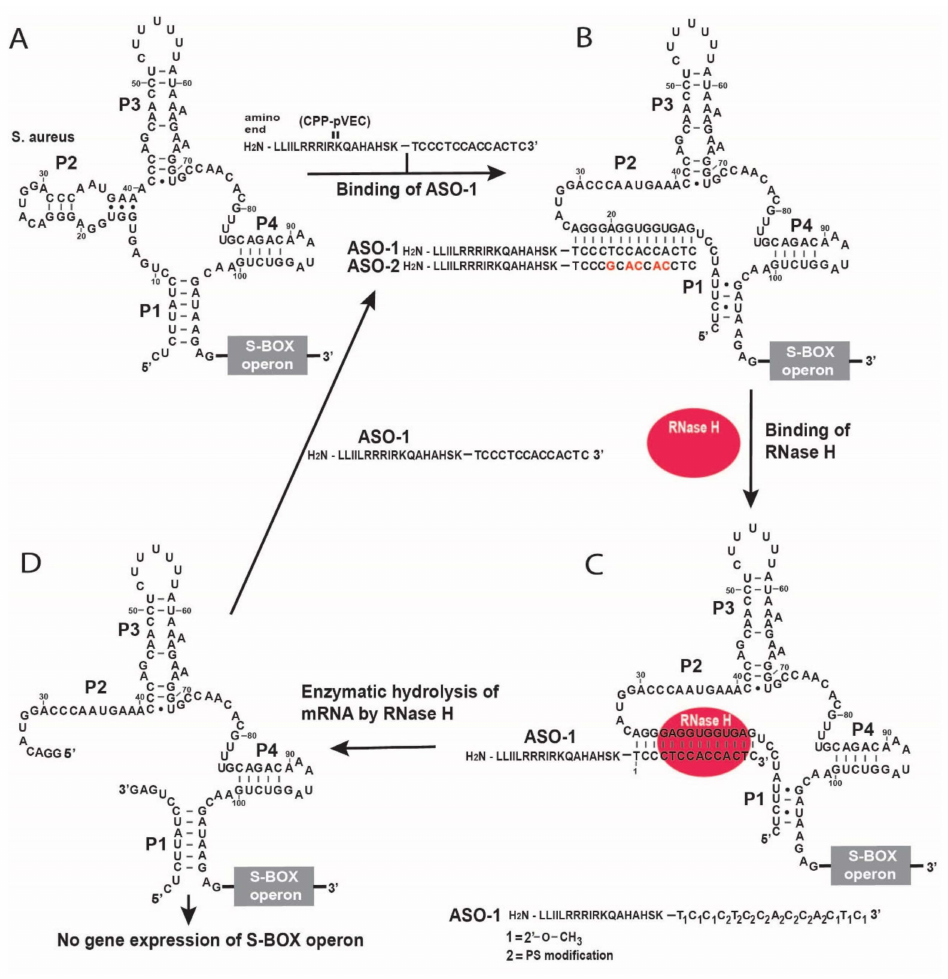
Figure 1. A chimeric antisense oligonucleotide pVEC-ASO-1 targets the SAM-I aptamer domain of the S-box polycistronic mRNA. ( A ) The chimeric antisense oligonucleotide binds to the comple- mentary sequence of the SAM-I aptamer domain. ( B ) A double-stranded molecule is formed after binding the chimeric antisense oligonucleotide with the SAM-I aptamer sequence. ( C ) The recog- nized double-stranded molecule by the RNase H is enzymatically hydrolyzed. ( D ) The enzymatic hydrolysis of RNA leads to no gene expression of the S-box